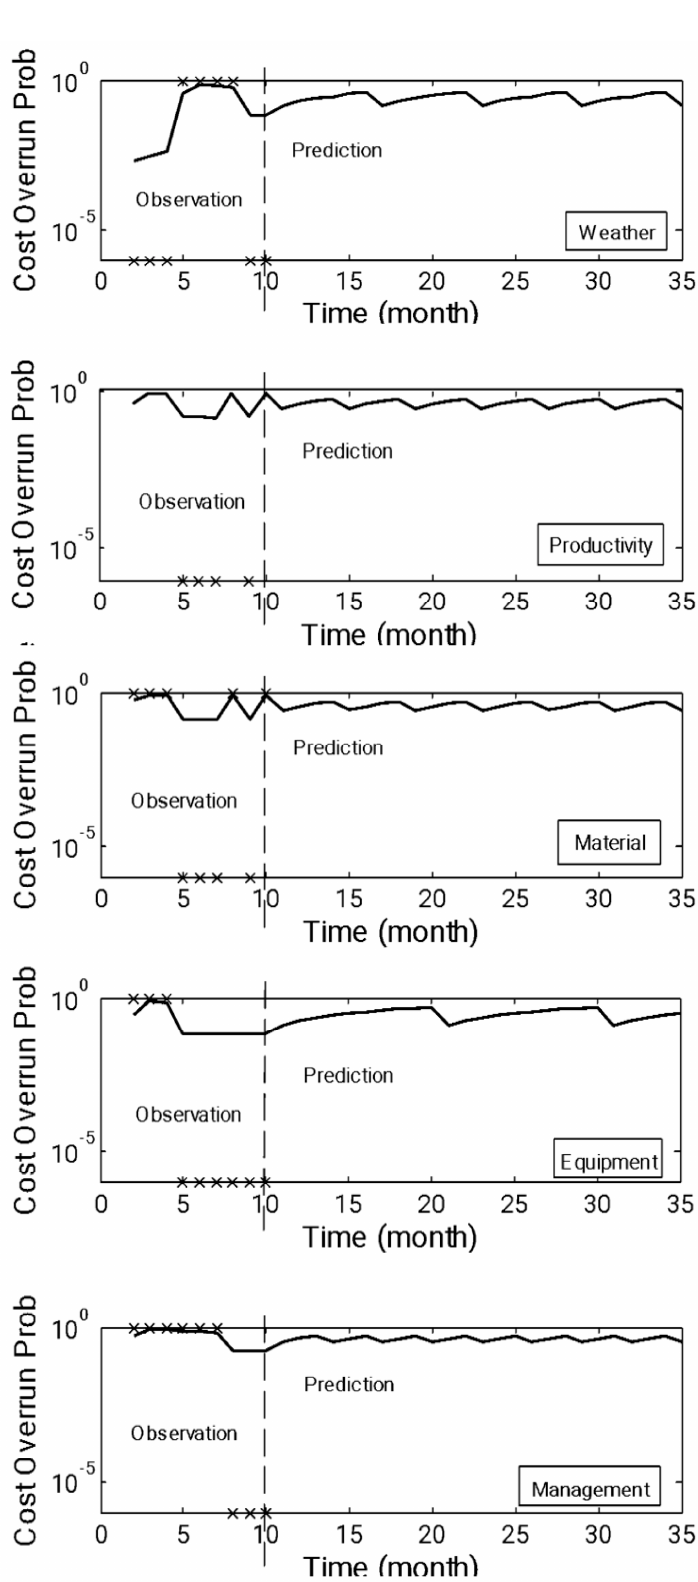
Figure 4. Cost Overrun Probability Trend for Each Influence Factor at SRC Project. Table 7. Comparison between Our Model and EVM.